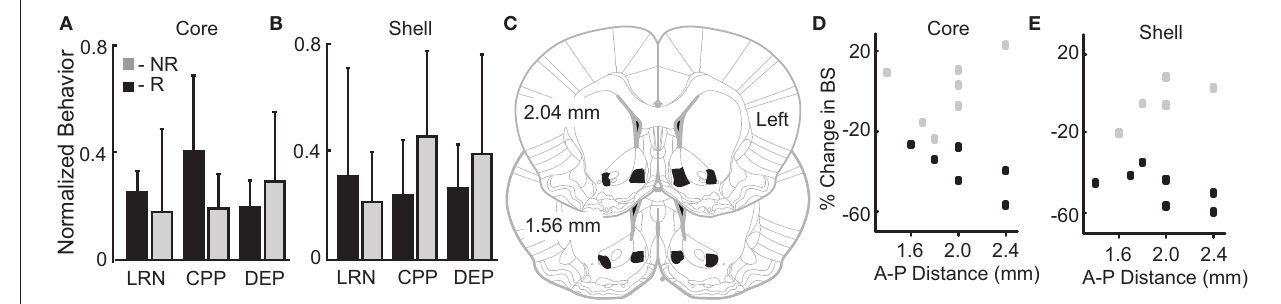
FIGURE 4 | Variation in reward-related behavior and electrode location does not relate to stimulation outcomes. Normalized behavioral data grouped by core (A) and shell (B) DBS response type–responders (R; black) and non-responders (NR; gray). No significant differences were observed between R and NR groups for the following outcomes: (1) total distance traveled during locomotor response to novelty (LRN); (2) change in the percent of time spent in the initially non-preferred chamber during conditioned place preference (CPP); and (3) percentage increase in food intake after 24h of food deprivation (DEP). (C) All rats included in the analysis had electrode locations within the bilateral NAc core and shell with electrodes localized within the black shapes collapsed onto two representative coronal sections. The largest variation in electrode positioning occurred along the anterior-posterior (A-P) dimension (1.4 to 2.4mm anterior to bregma). No discernable relationship between electrode placement along the A-P axis in NAc core (D) or shell (E) corresponded to stimulation outcomes – responder (black) or non-responder (gray).